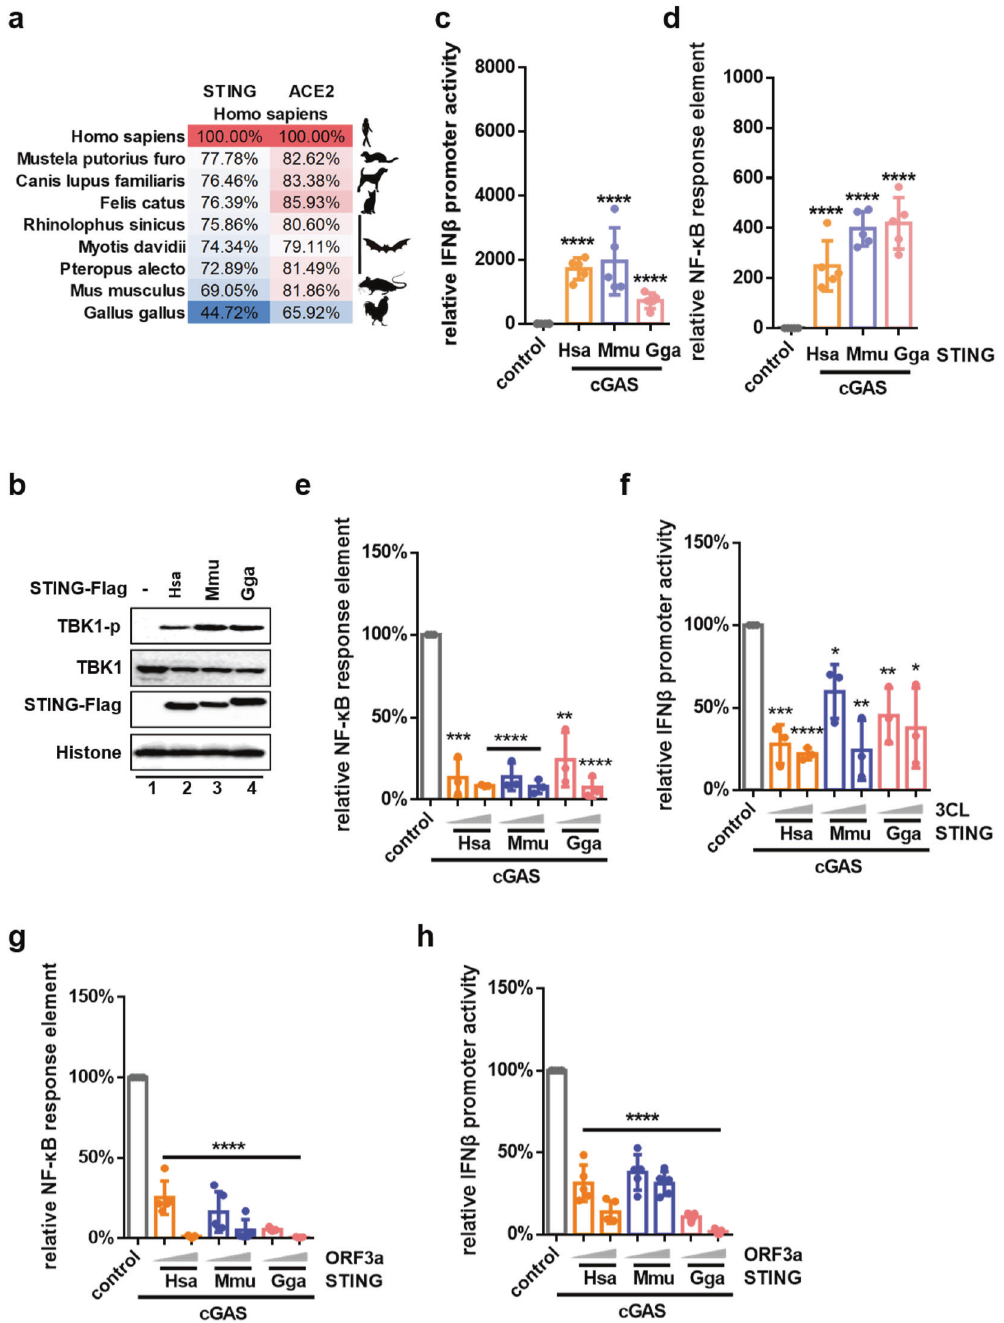
Fig. 5 Human, mouse, and chicken STING function can be suppressed by SARS-CoV-2 3CL. a Percentage of amino acid identity of representative vertebrate STING molecules as compared to Homo sapiens STING [ Homo sapiens (NP_938023.1), Felis catus (AMD40259.1), Canis lupus familiaris (XP_022263973.1), Mustela putorius furo (XP_012907883.1), Myotis davidii (XP_006772500.1), Pteropus alecto (XP_006923104.1), Rhinolophus sinicus (XP_019595754.1), Mus musculus (NP_082537.1), and Gallus gallus (NP_001292081.1)]. Identities of human ACE2 with representative vertebrate ACE2 are shown for comparison. b Homo sapiens , Mus musculus , and Gallus gallus STING molecules can promote TBK1 phosphorylation in human cells. HEK293T cells were co-transfected with the cGAS and Homo sapiens , Mus musculus , or Gallus gallus STING expression vectors, respectively. Cells were harvested 24 h after transfection, and the protein expression levels were analyzed by immunoblotting with anti-Flag, anti-TBK1, anti-TBK1-p, or anti-Histone antibody. c , d Homo sapiens , Mus musculus , and Gallus gallus STING can all stimulate IFN β ( c ) promoter and NF- κ B- ( d ) response element activity. HEK293T cells were transfected with IFN β -Luc ( c ) or NF- κ B-Luc ( d ) and pRL-TK Renilla, together with Myc-cGAS and each of the three vertebrate STING molecules described previously. e – h SARS-CoV-2 3CL ( e , f ) and ORF3a ( g , h ) inhibit vertebrate STING function in a dose-dependent manner. HEK293T cells were transfected with NF- κ B-Luc ( e , g ) or IFN β -Luc ( f , h ) and pRL-TK Renilla, together with STING-Flag and Myc-cGAS and increasing amounts of the 3CL ( e , f ) or ORF3a ( g , h ) expression vectors. Luciferase activity induced by cGAS-STING alone was used as a positive control and set to 100%. Transactivation of the luciferase reporter was determined 24 h after transfection ( n ≥ 3 independent biological experiments). Means and standard deviations are presented. The statistical signi fi cance analyses were performed using a two-sided unpaired t test, * p < 0.05; ** p < 0.01; *** p < 0.001; **** p <